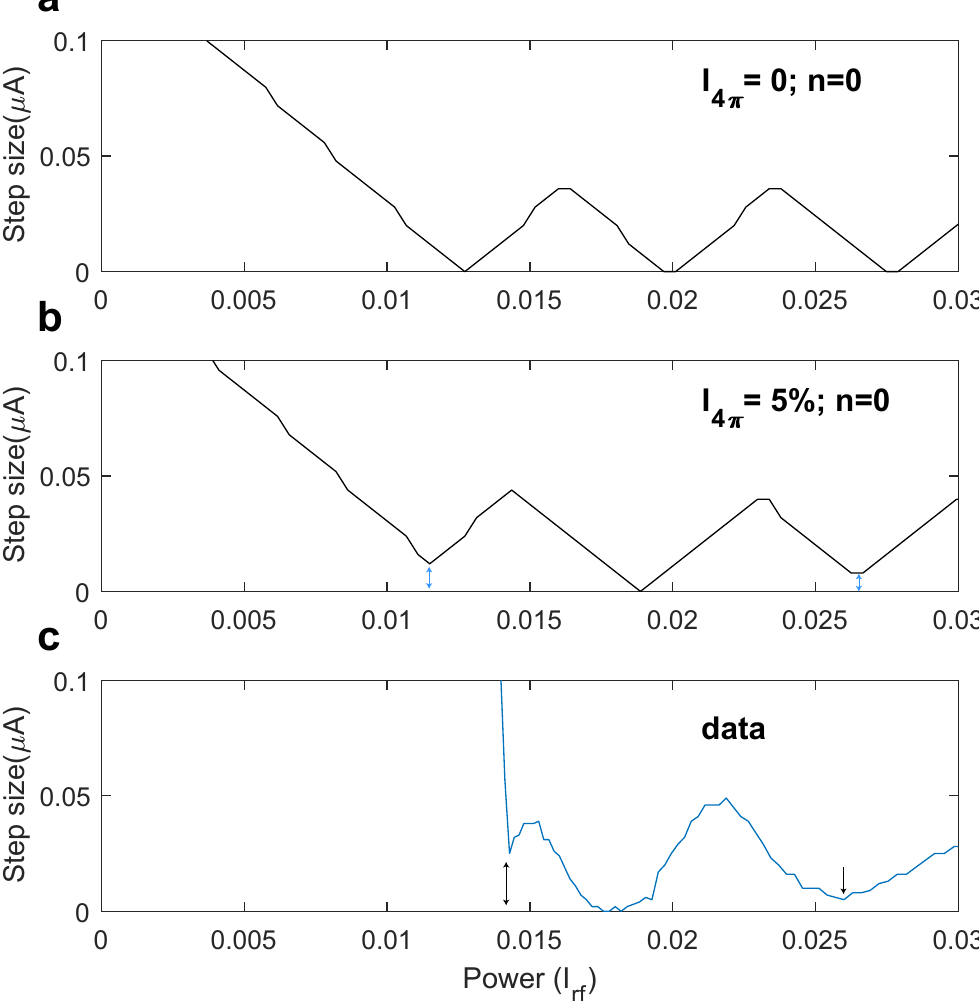
Figure 3. ( a ) Modeled step size of the zeroth order Shapiro step. No 4 π -periodic contribution to the supercurrent was added. The step size reduces to zero periodically. ( b ) Modeled step size of the zeroth order Shapiro step with a 5% 4 π -periodic contribution to the supercurrent. The step size does not completely reduce to zero at odd minima in the function. ( c ) Extracted step size data of junction 1a at 20 mK and 4.7 GHz radio frequency irradiation. The second minimum dips down deeper than the first and third minima, suggesting the presence of a 4 π -periodic component of the